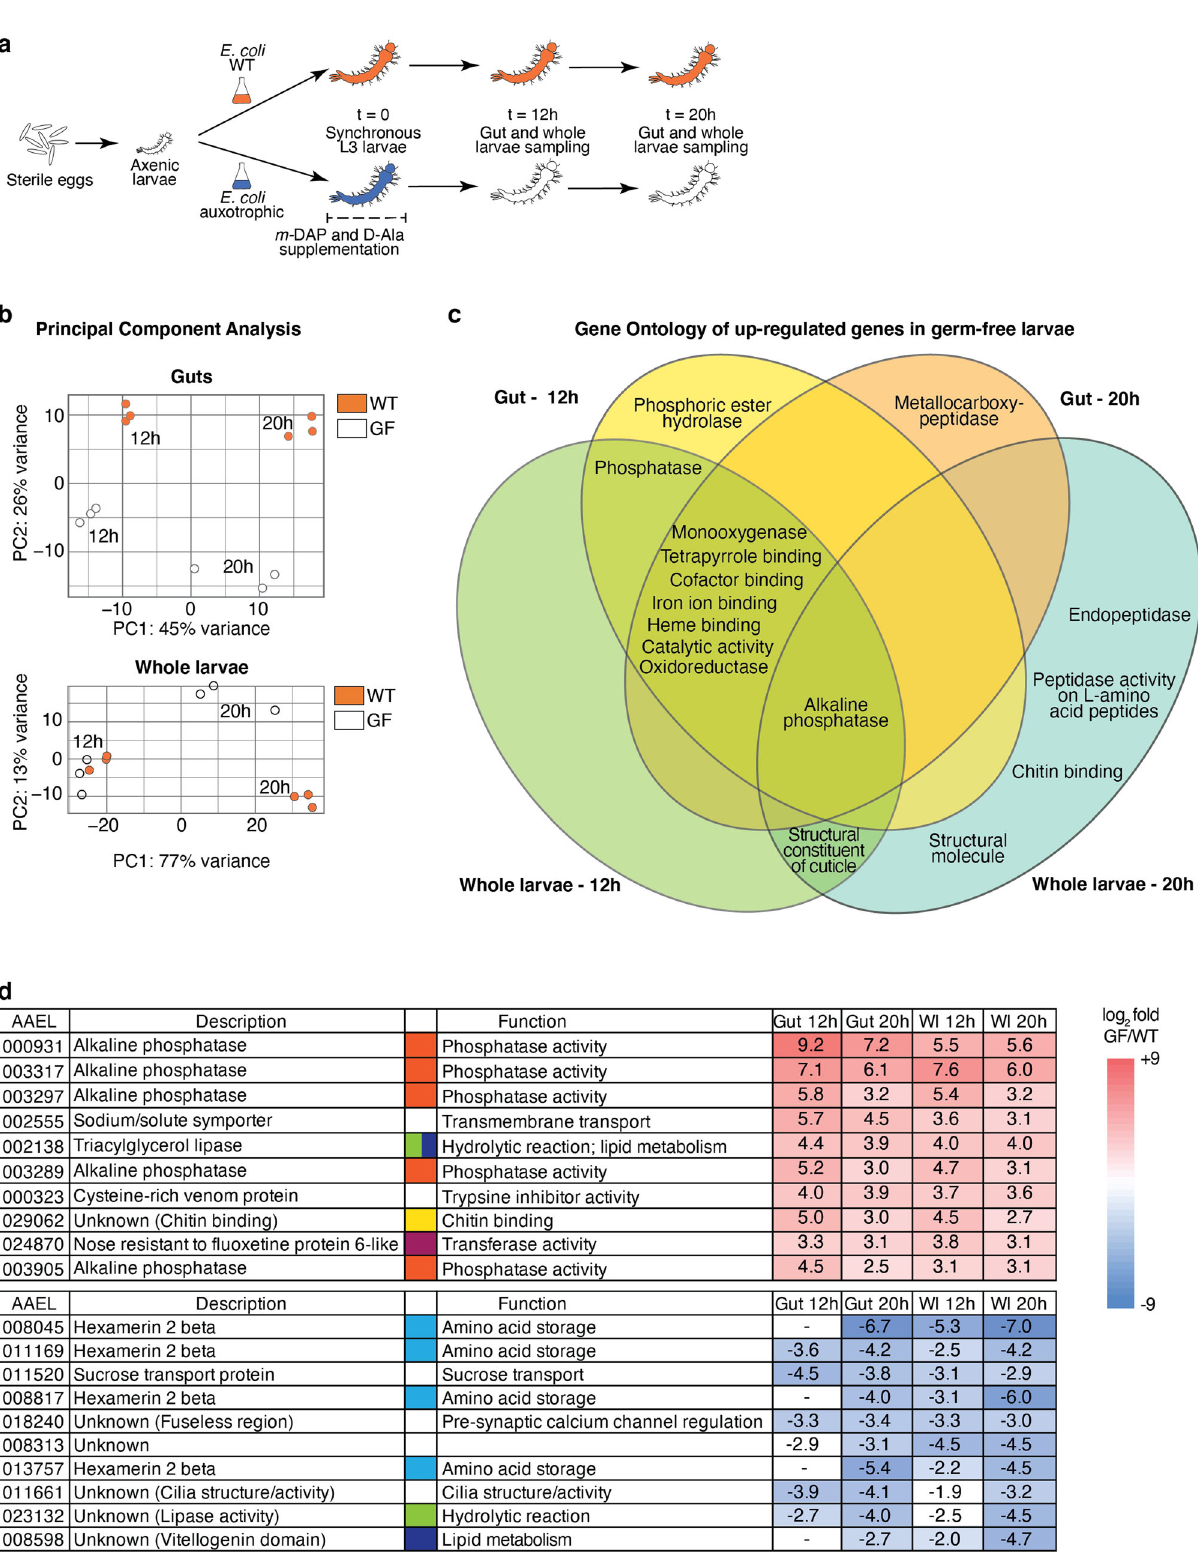
500. A total of 2735 transcripts were signi fi cantly differentially regulated (adjusted p < 0.001) in at least one sample type at one time-point. The sample distance heatmap showed that for each tissue type and time-point, the three experimental replicates clustered together (Fig. S9). The principal component